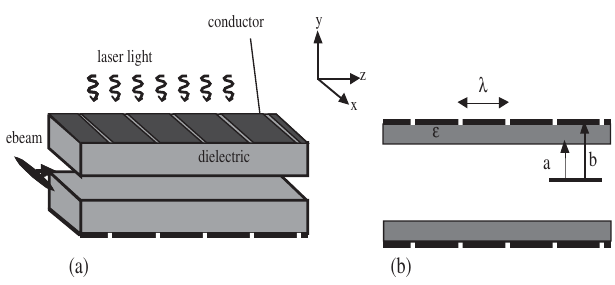
FIG. 1. (a) Schematic drawing of the structure geometry. Two layers of dielectric-lined conductor surround a vacuum gap; a very wide electron beam is injected into the gap and travels in the (cid:3) z direction, while radiation (polarized in z ) is coupled in from above through transverse slots in the conductor. (b) A cross-section in x , showing the parameters used in the